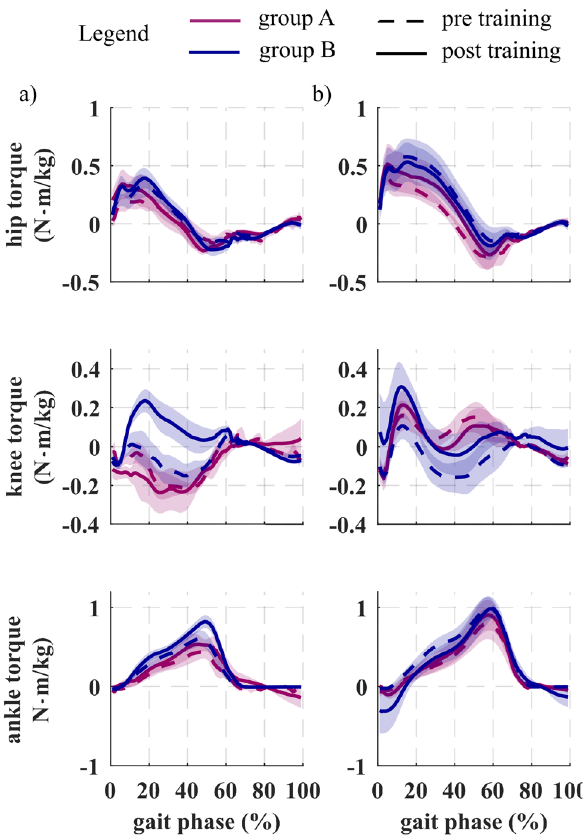
Figure 7. Lower-limb kinetics averaged across group participants pre and post training. Joint kinetic profiles of the paretic ( a ) and non-paretic ( b ) hip, knee and ankle joints measured during the pre-training (dashed lines) and post-training (solid lines) gait analysis for the group A (purple) and the group B (blue). Data are shown aggregated across group participants as mean ± standard errors (n = 6 group A, n = 8 group